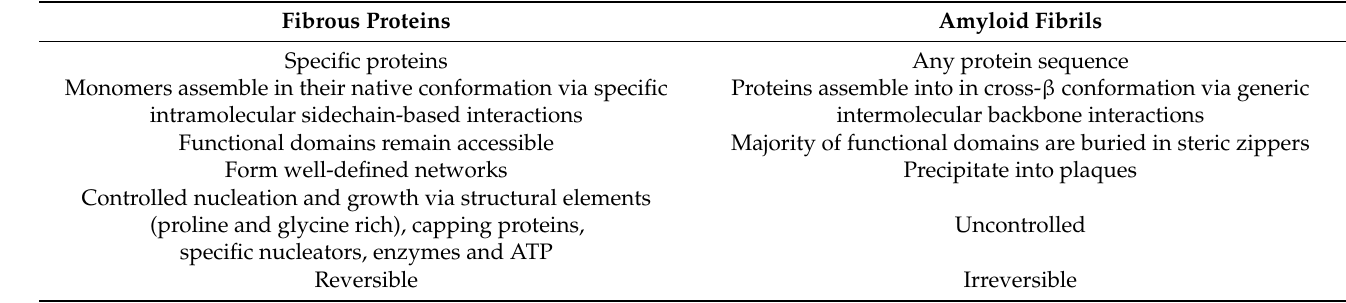
Table 1. The differences between fibrous proteins and amyloid